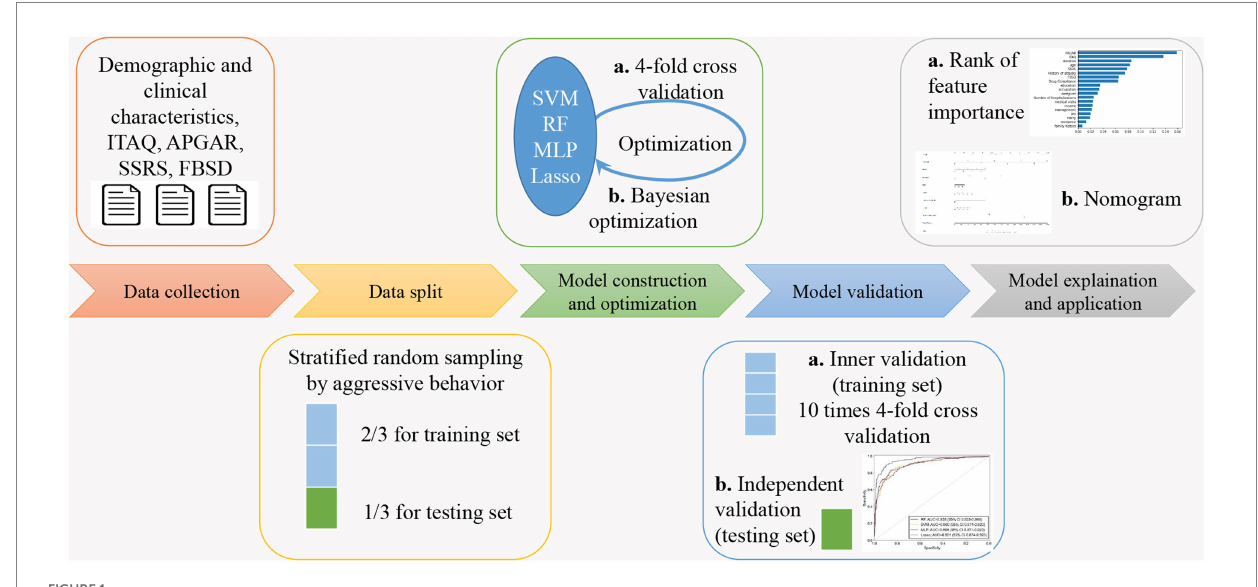
FIGURE 1 The flowchart of the